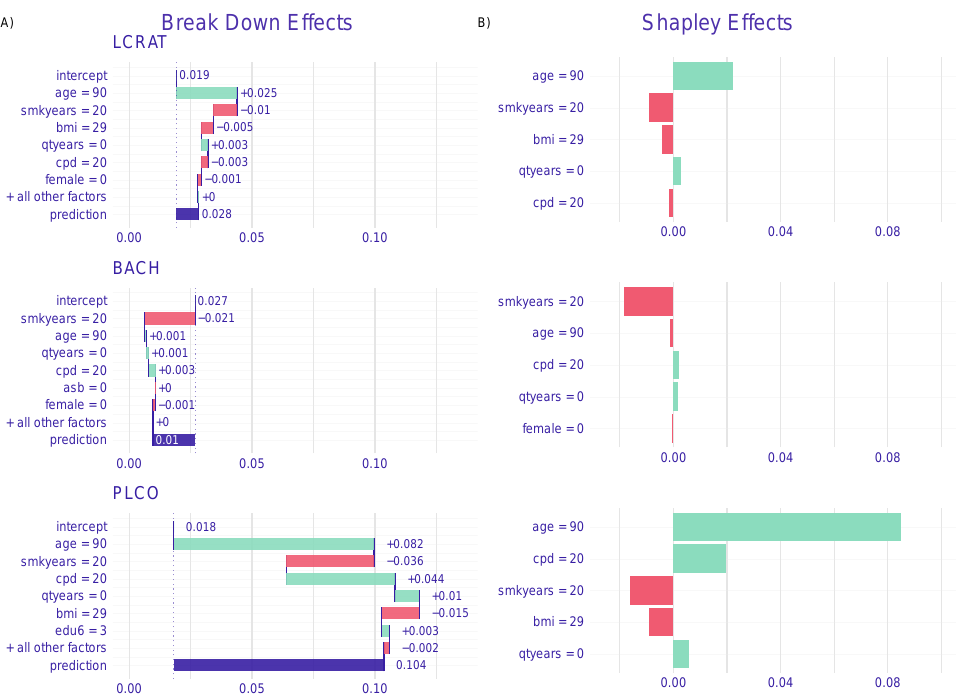
Figure 4. The first column ( A ) presents break down plots for additive attributions. The second column ( B ) presents Shapley additive explanations. ( A ) The deep purple bar indicates the final prediction for a chosen patient. The plot also shows the contributions of each variable to the final prognosis. Green bars indicate positive contributions, meaning that the value of a certain variable implies an increase in prediction. By analogy, red bars suggest a negative contribution. The larger the bar is, the larger its contribution. ( B ) Green and red bars indicate the Shapley values and present the positive and negative contributions to the final